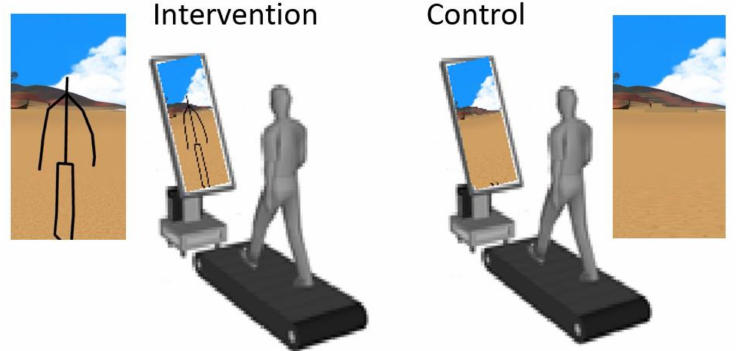
Figure 1. Schematic of the setup (incl. hardware and software) for capture of gait data during the trials. The setup includes a treadmill, screen (in portrait mode), the Kinect v2™ sensor (placed before the screen), an attached computer and associated software required for the